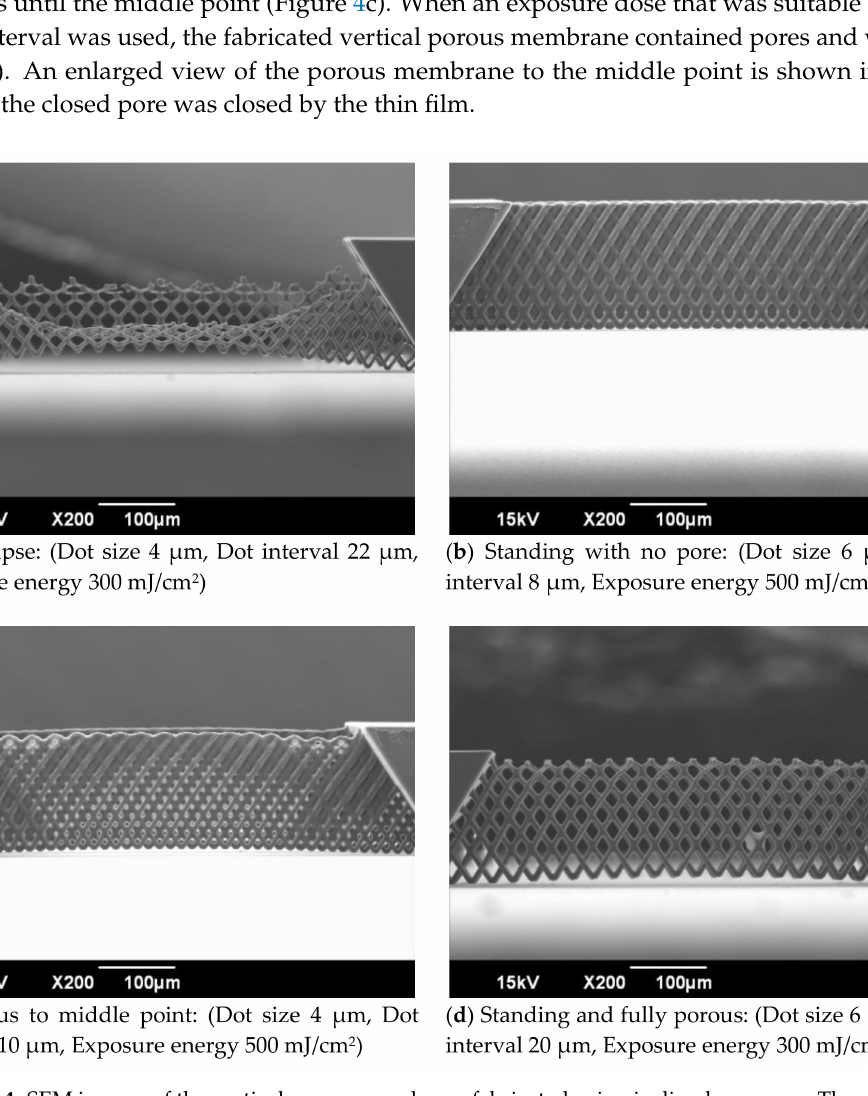
Figure 4. SEM images of the vertical porous membrane fabricated using inclined exposure. The vertical porous membrane was fabricated by changing the dot size, interval, and exposure dose. The fabricated structures are divided to ( a ) collapse, ( b ) standing with no pore, ( c ) porous to middle point, or ( d ) standing and fully